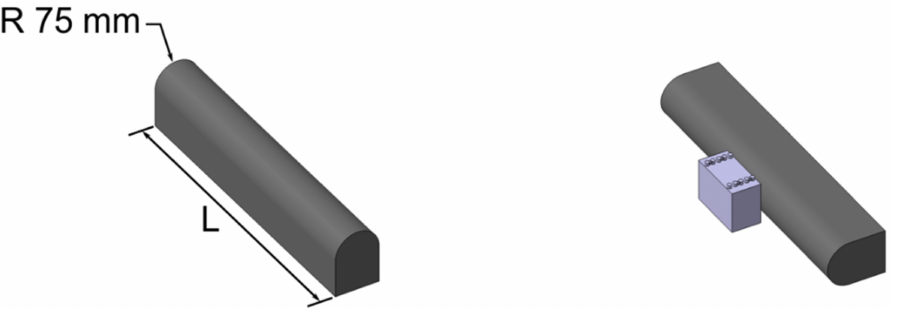
Figure 3. Module crush board as per GB/T 31485-2015:2015 [40].